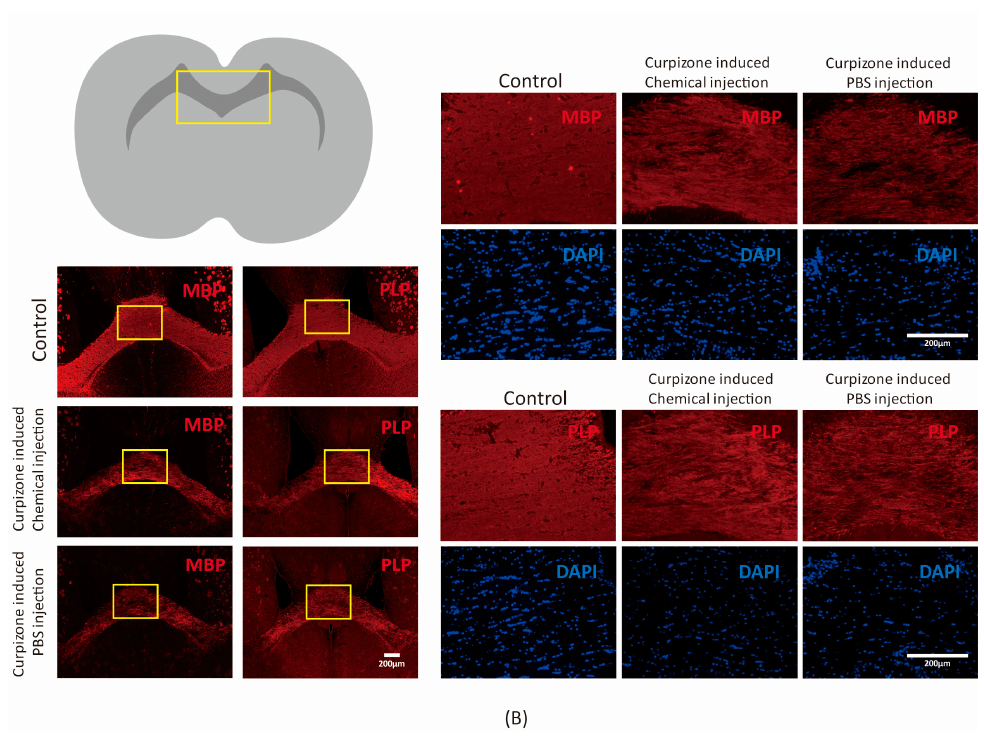
Figure 6. Chemical cocktail injection rescues cuprizone-induced demyelination in mice. Induction of demyelination in B6 mice by cuprizone. The YSF cocktail and PBS were injected directly into the corpus callosum of mice; then, the mice were allowed to recover for two weeks before dissection. YSF refers to Y27632, SU9516, and forskolin. ( A ) Luxol fast blue staining was performed to detect the remyelination process in the corpus callosum. The quantification of Luxol fast blue was compared between the YSF-cocktail- and PBS-injected groups after 2 weeks of recovery before dissection. Data are presented as mean ± standard deviation. ( n = 6). Significant differences were determined by ANOVA followed by Sidak’s multiple comparisons test, * p < 0.05, ** p < 0.005, *** p < 0.001, **** p < 0.0001. ( B ) After 2 weeks of recovery, immunofluorescence staining was performed to observe the protein expression of the YSF-cocktail- and PBS-injected groups. Comparison of myelination densities for MBP (top) and PLP (bottom) protein expression in the corpus callosum of the YSF-cocktail- and PBS-injected groups. DAPI (blue) was used to stain nuclei.